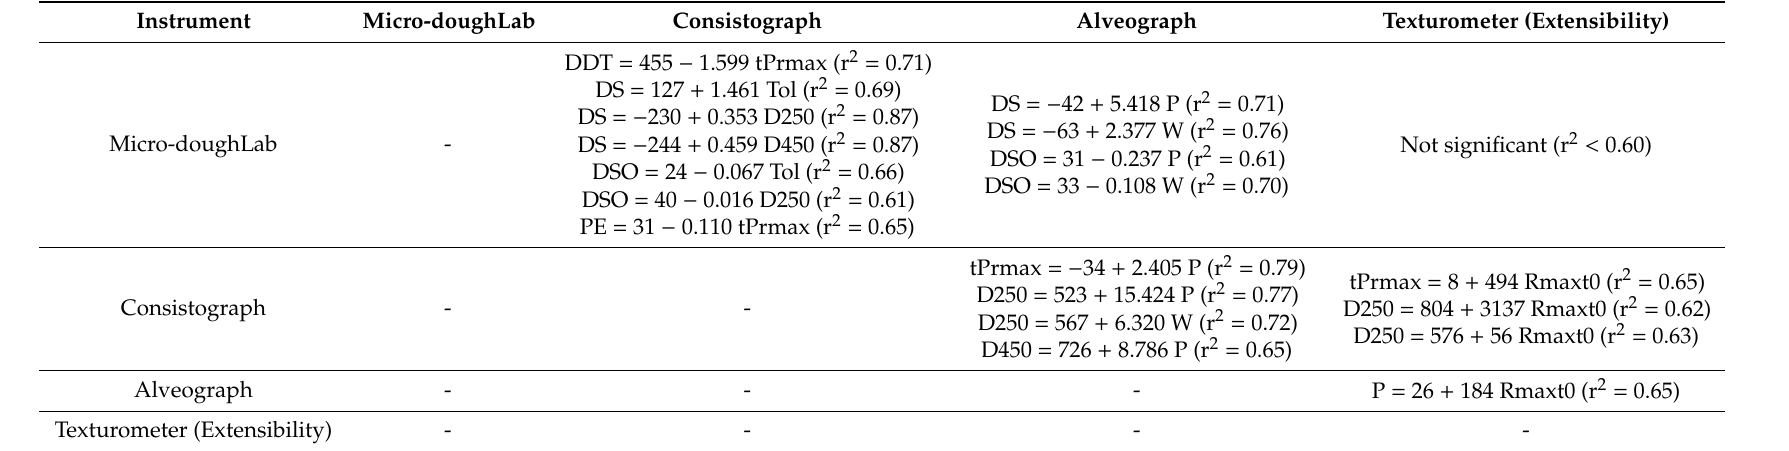
Table 4. Correlations between dough rheology parameters obtained from empirical tests ( p <